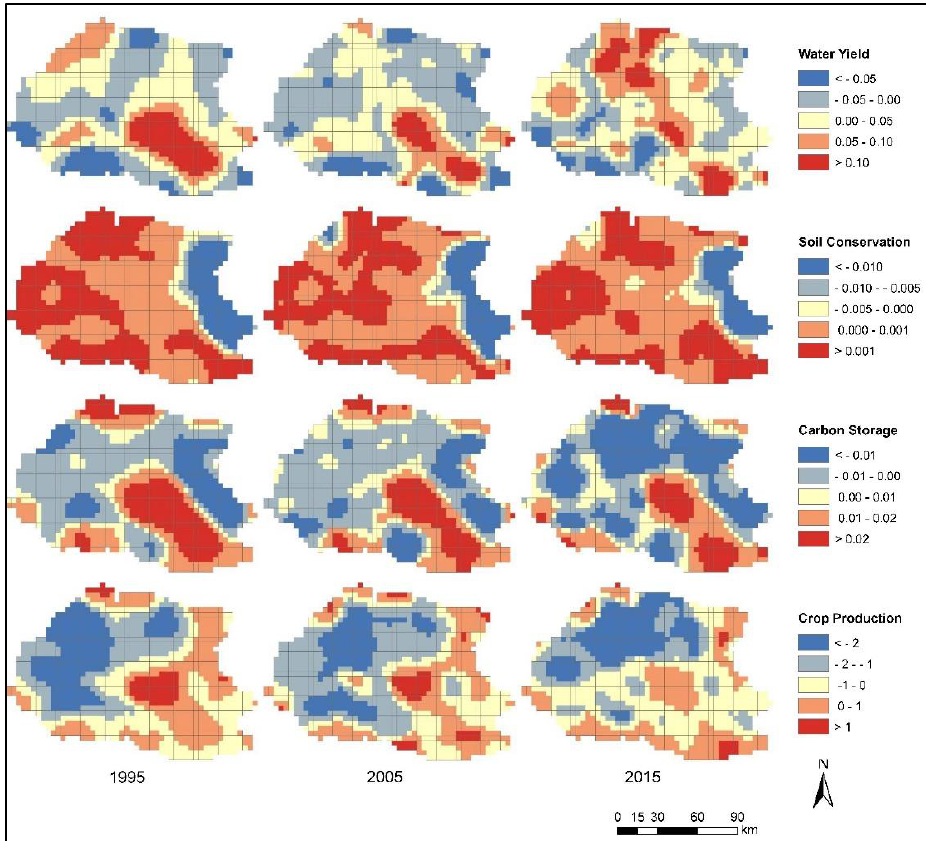
Figure 8. Spatial distributions of correlation coefficients between mean shape index (SHAPE_MN) and ecosystem services.